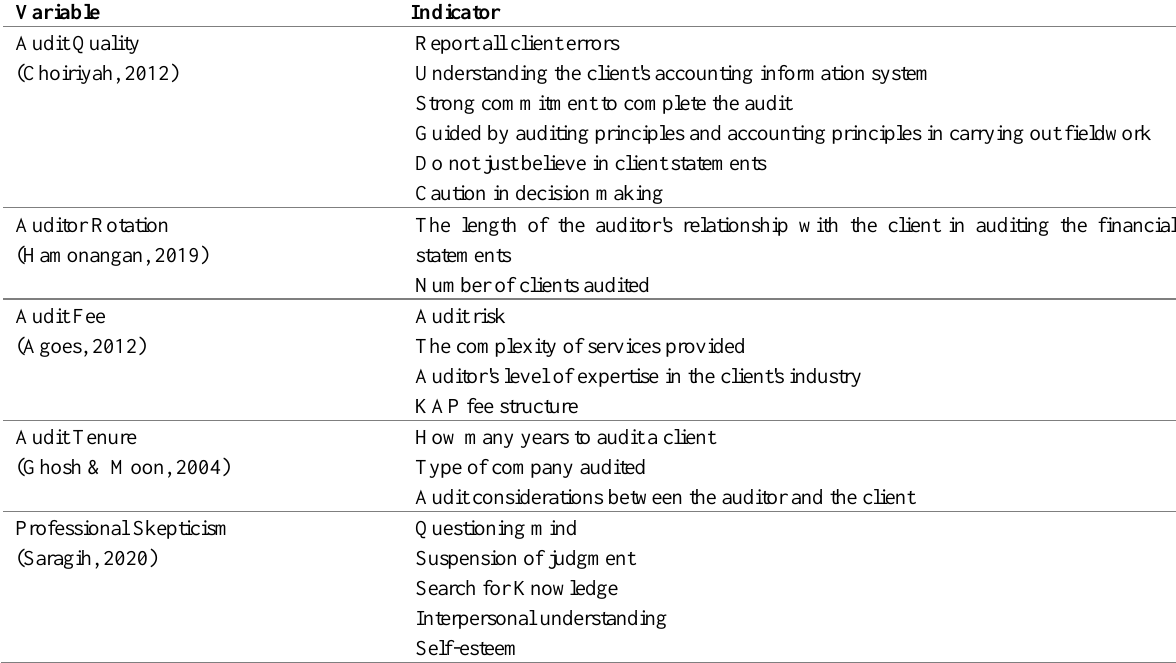
Table 1: Operational Measurement Variable